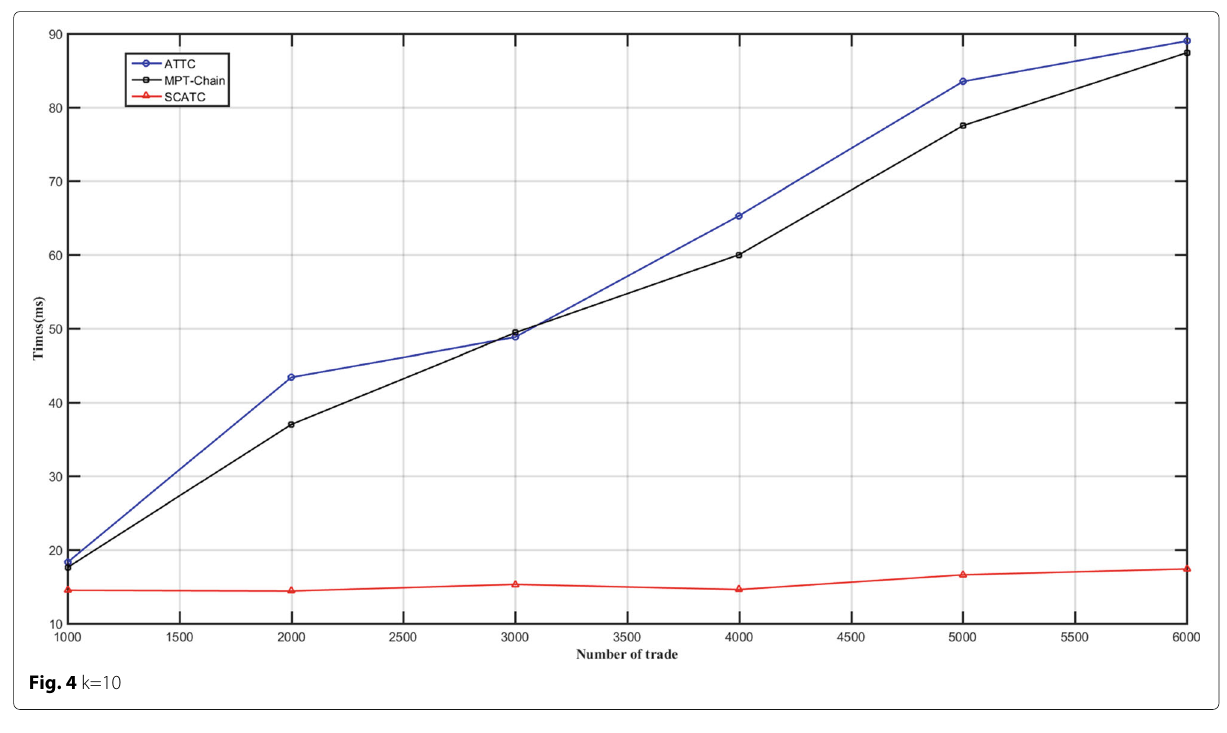
the ATTC scheme, MPT-Chain pointers are not embed- ded in specific transactions, so there is no need to access specific transactions. The number of query operations performed by the system is λ( h 3 ) = p 3 × h 3 , and the time complexity of the algorithm can be expressed